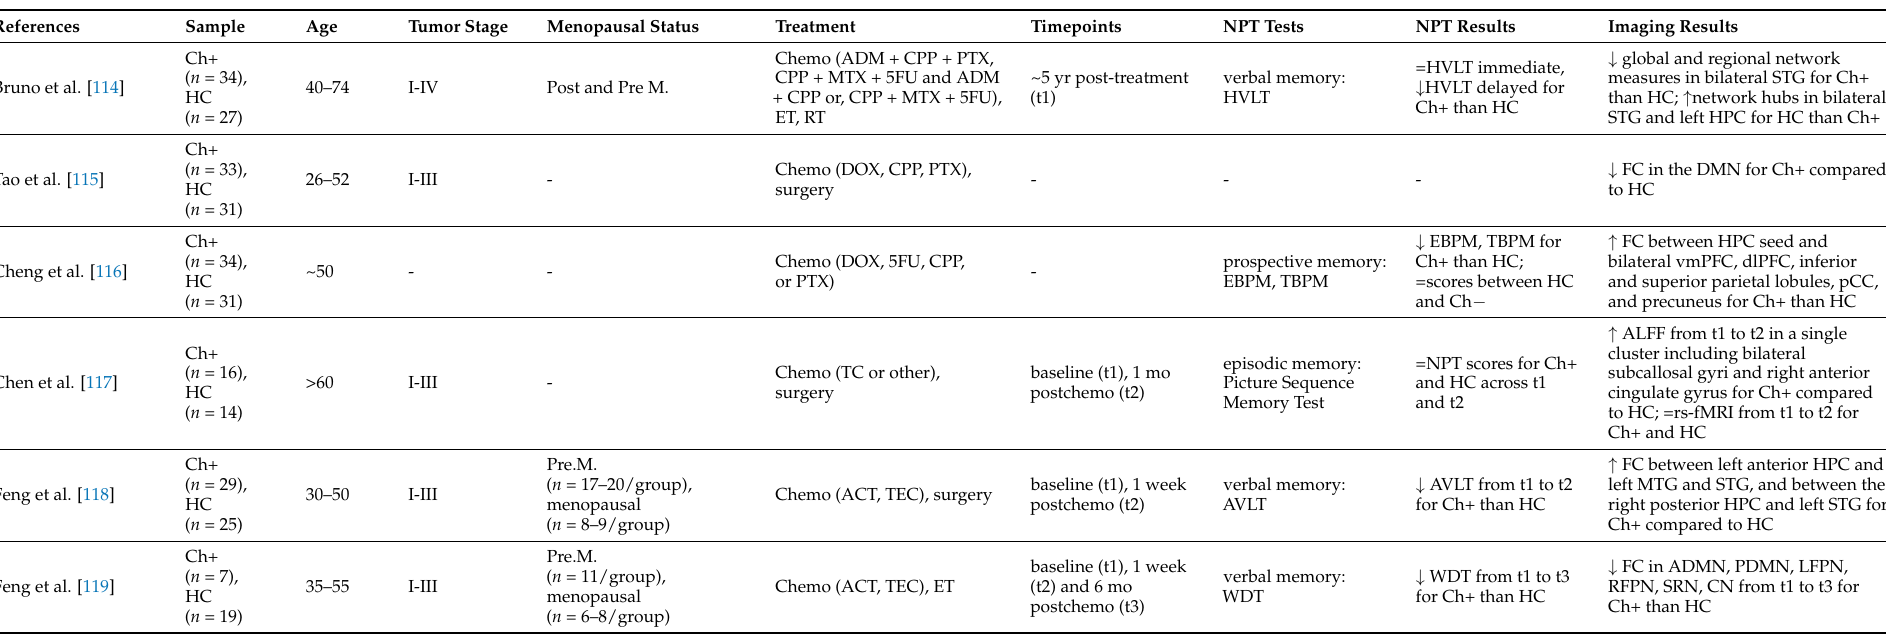
Table 3. Summary of reports identifying chemotherapy-induced functional differences in the temporal lobes during resting state fMRI in breast cancer